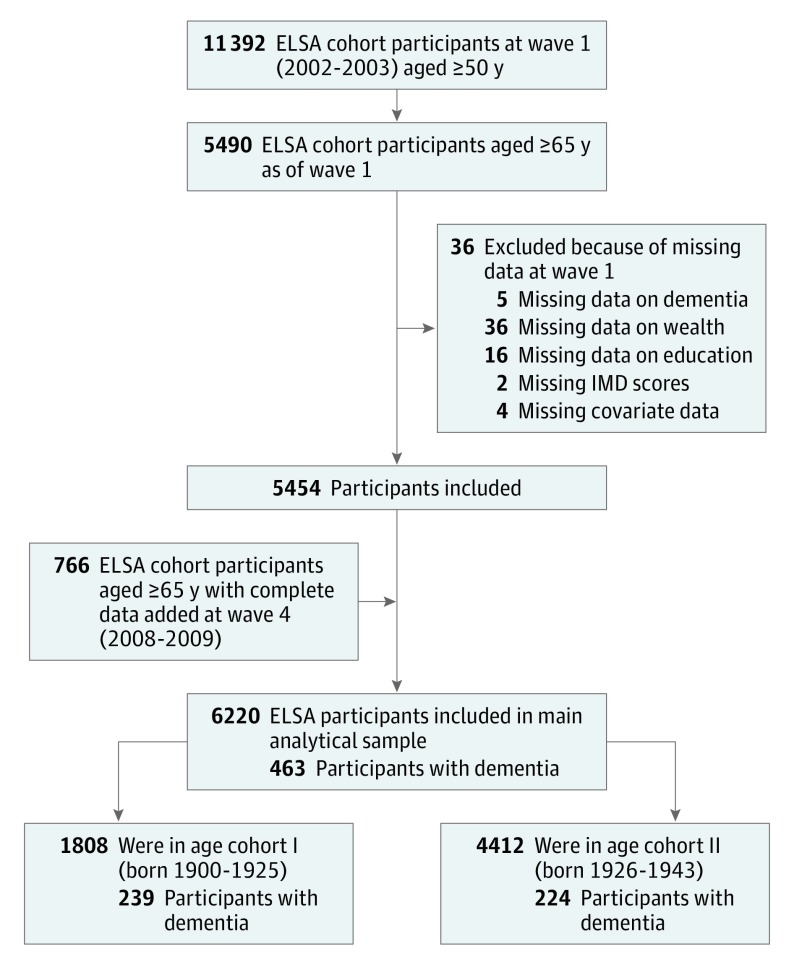
Flowchart of the Individuals Included in AnalysesNumbers of excluded persons are nonmutually exclusive. ELSA indicates the English
Longitudinal Study of Ageing; IMD, index of multiple deprivations.